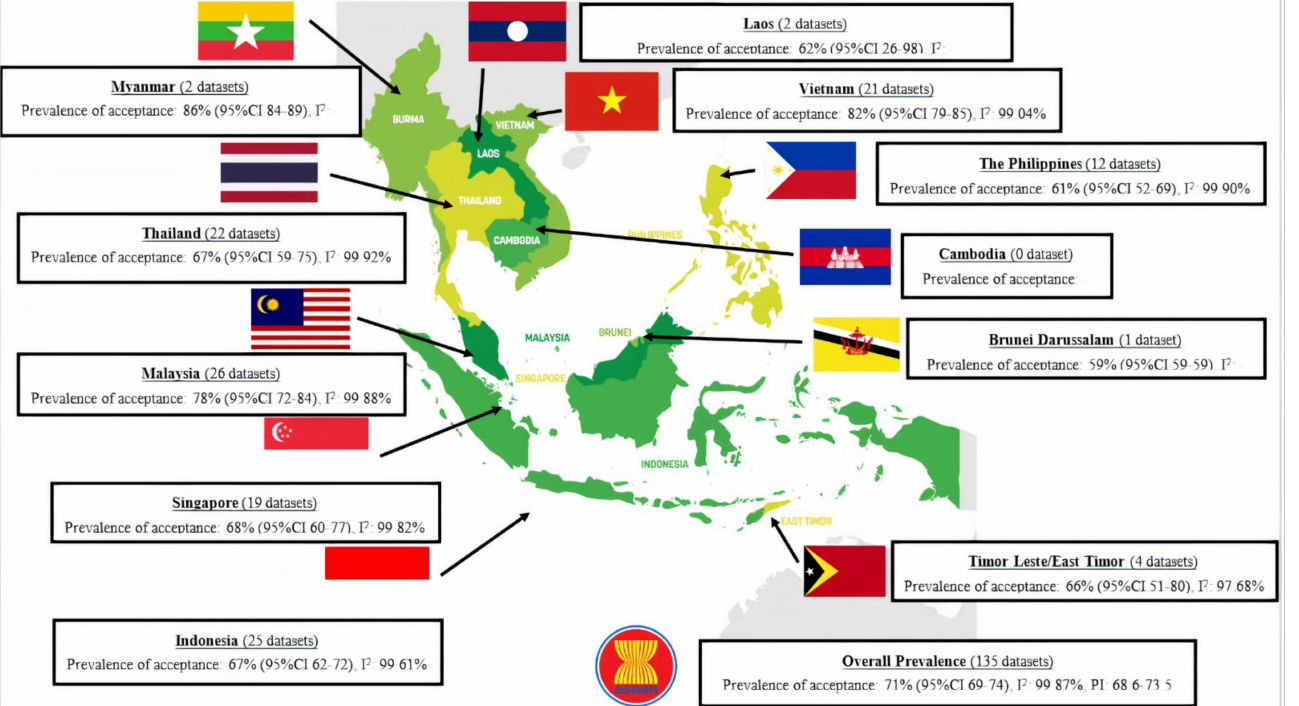
Figure 2. Prevalence of COVID–19 Vaccine Acceptance in South East Asia.